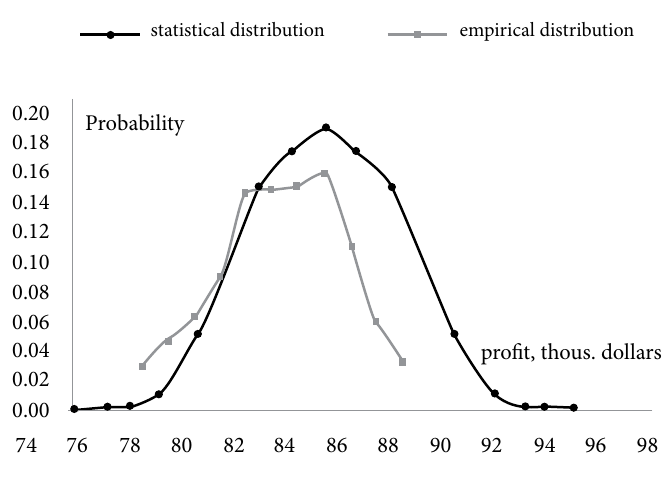
Fig. 2. Discrete probabilities distribution for obtaining certain profit